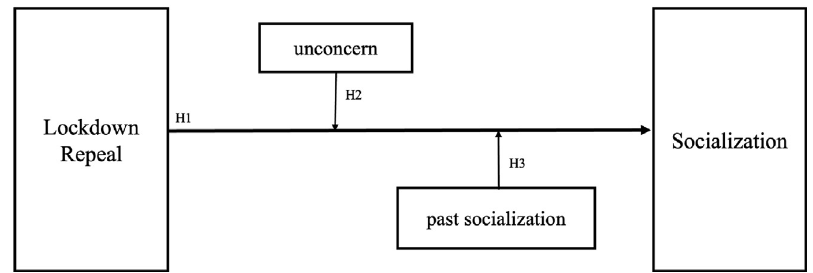
Fig. 1. Conceptual